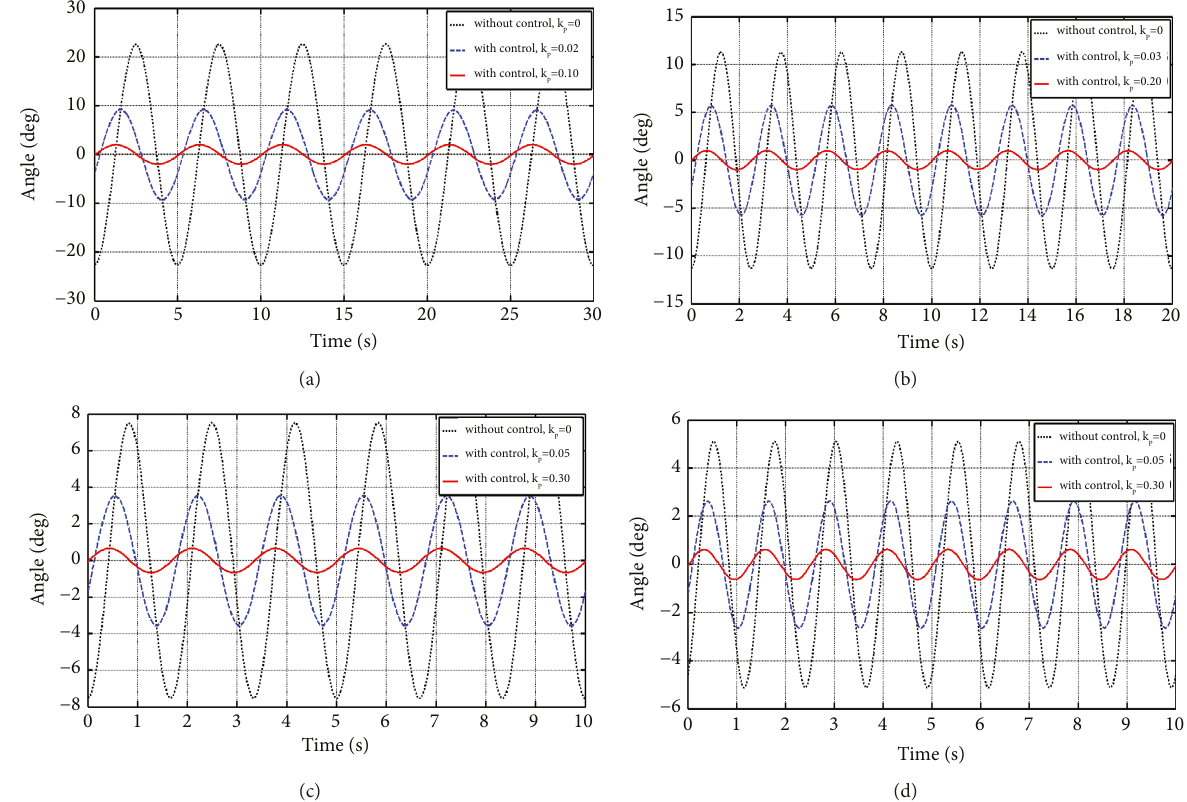
Figure 6: Simulation results of vibration control excitation at (a) 0.2, (b) 0.4, (c) 0.6, and (d) 0.8Hz.